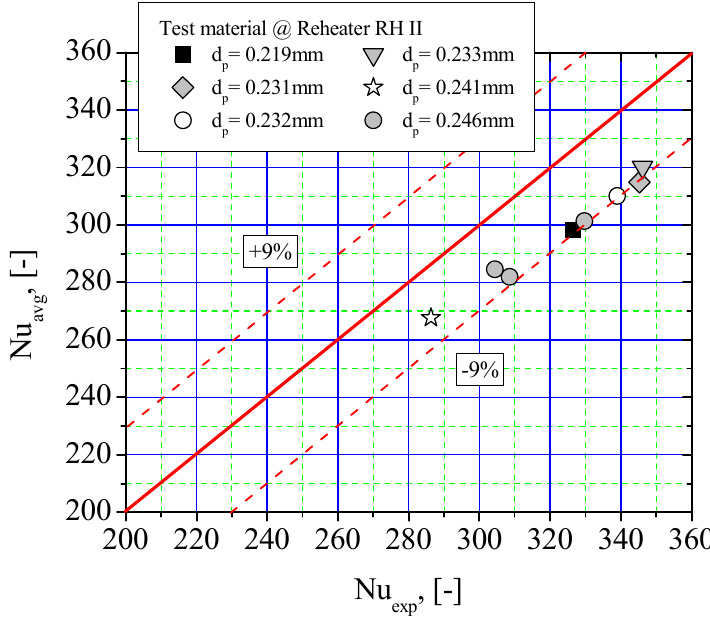
Figure 11. Comparison experimental Nusselt number with predicted Nusselt number.